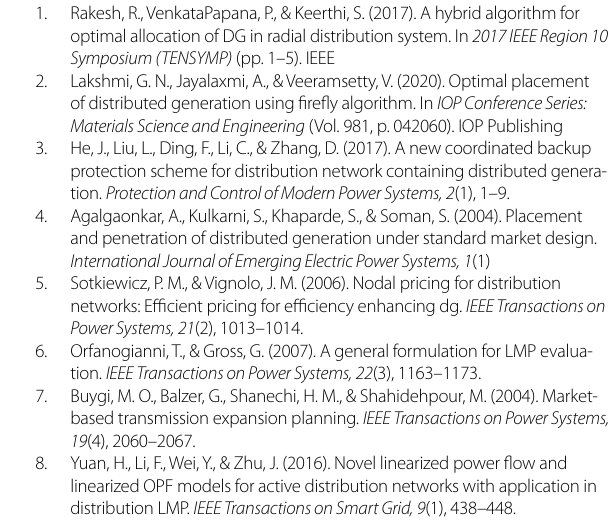
: Penalty for the emission of CO 2 in ($/kg); P CO : Penalty for emission of 2 CO in ($/kg); P NO : Penalty for the emission of NO x in ($/kg); P SO : Penalty for the x 2 emission of SO 2 in ($/kg); Ploss t 0 : Base case active power loss at hour t (MW); Ploss t DG : Active power loss of the system with a DG unit at hour t (MW); Ploss t j : System loss with DG units at hour ‘h’ and iteration ‘j’; SO DG i 2 : Amount of SO 2 released from DG unit ‘i’ (kg/MW); SO Sub 2 : Amount of SO 2 released based on substation bus load (kg/MW); v k ( C ) : Loss(k l)/emission(k e) reduction due = = to coalition C; v k ( C − i ) : Loss(k l)/emission(k e) reduction due to coalition = = C with out DG ‘i’; benefit 0 t : Base case DISCO’s benefit at hour ‘t’ in ($); benefit jt : DISCO’s benefit with DG at hour ‘t’ and iteration ‘j’ ($); EC 0 t : Green house Gas emission penalty at hour h in the base case in ($); EC DGt : Green house Gas emission penalty at hour h with the DG units in ($); EC jt : Emission penalty for network at hour ‘t’ and iteration ‘j’ in ($); Emn jt : Emission from network at hour ‘t’ and iteration ‘j’ in kg; MAPE: Mean Absolute Percentage Error; RMSE: Root Mean Square Error; xEmn(i): Share of DG ‘i’ in emission reduction (kg); xLoss(i): Share of DG ‘i’ in loss reduction (MW).